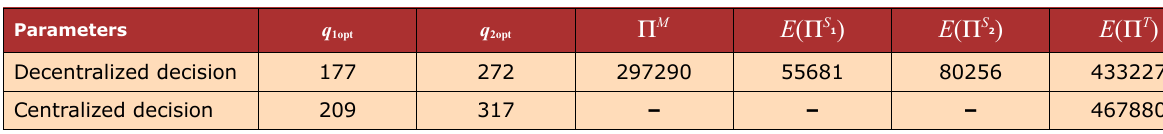
Table 1. Decentralized Decision Compared with Centralized Decision